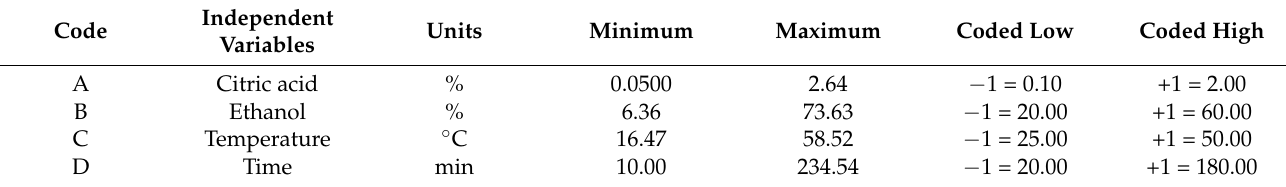
Table 1. Range of values for the factors investigated and encoded